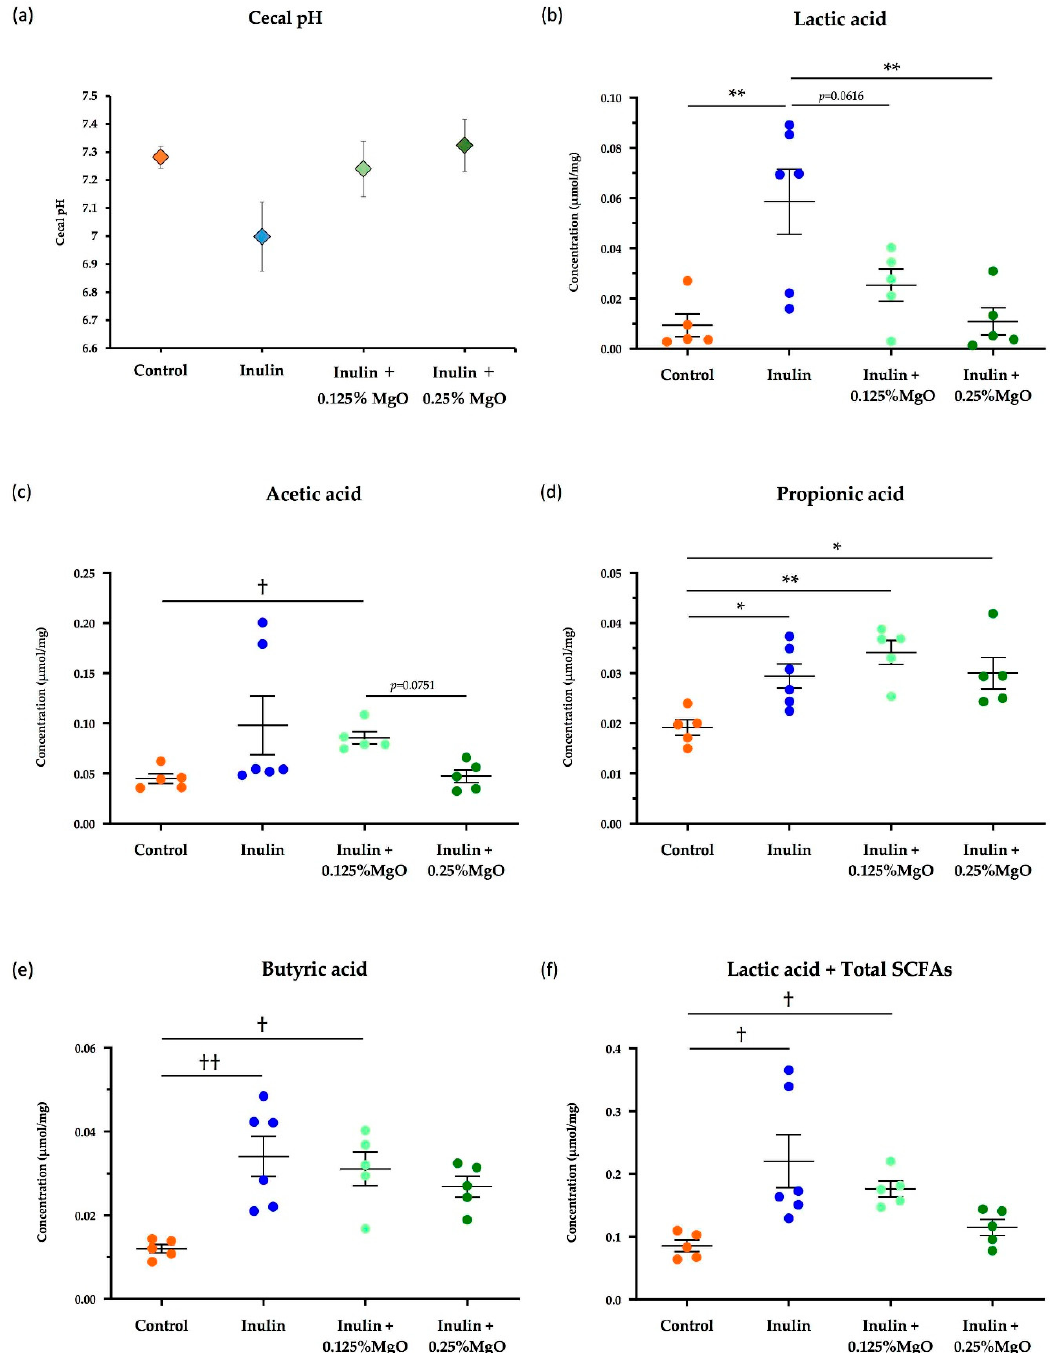
Figure 2. The combined inulin and MgO effects on cecal pH and SCFAs in mice on a normal diet. ( a ) Cecal pH. ( b ) Lactic acid concentration of the cecal content. ( c ) Acetic acid concentration of the cecal content. ( d ) Propionic acid concentration of the cecal content. ( e ) Butyric acid concentration of the cecal content. ( f ) Lactic acid concentration + total SCFA concentration of the cecal contents (Total SCFA concentration is the total sum of the acetic acid concentration, propionic acid concentration, and butyric acid concentration). AIN93-M was used as the diet, and inulin was mixed with the diet at a ratio of 2.5% in the inulin group and the MgO combination group. Magnesium oxide was given in the diet at a ratio of 0.125% or 0.25%. Concentrations of lactic acid and each SCFA were calculated per dry weight of the cecal contents. All data are expressed as mean ± standard error (Each group n = 5–6). * p < 0.05 and ** p < 0.01, evaluated using the one-way ANOVA with Tukey’s post hoc test. † p < 0.05, †† p < 0.01, evaluated using the Kruskal-Wallis test with Dunn’s post hoc test. MgO: magnesium oxide. SCFA: short-chain fatty